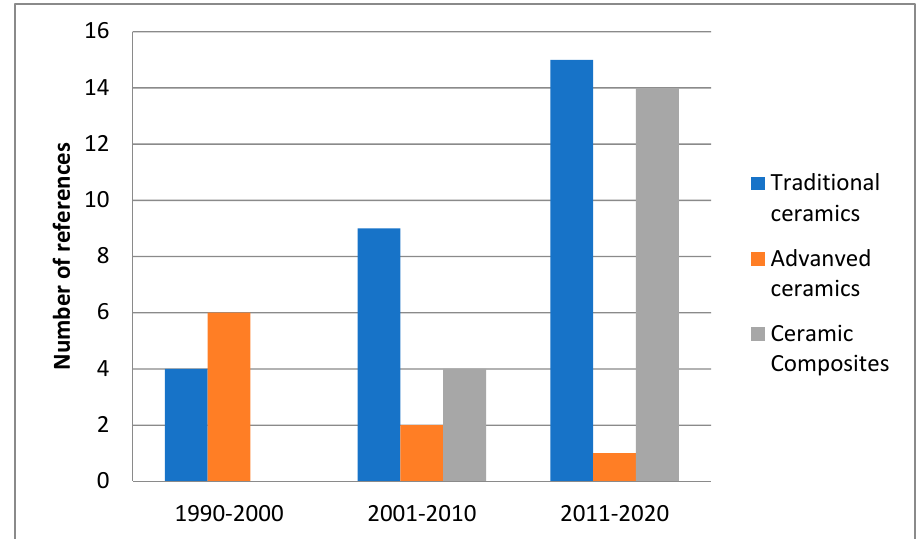
Figure 11. % Participation of the literature (of 55 references) on the different halloysite-based ceramics of the current review.